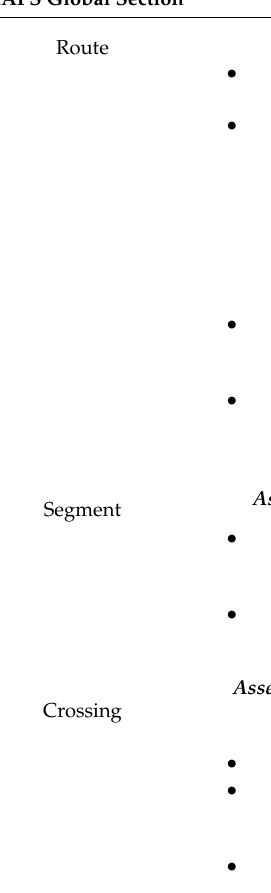
Table 1. Comparison between original MAPS Global auditing processes and modification of MAPS Global for assessment of school neighbourhood. MAPS Global